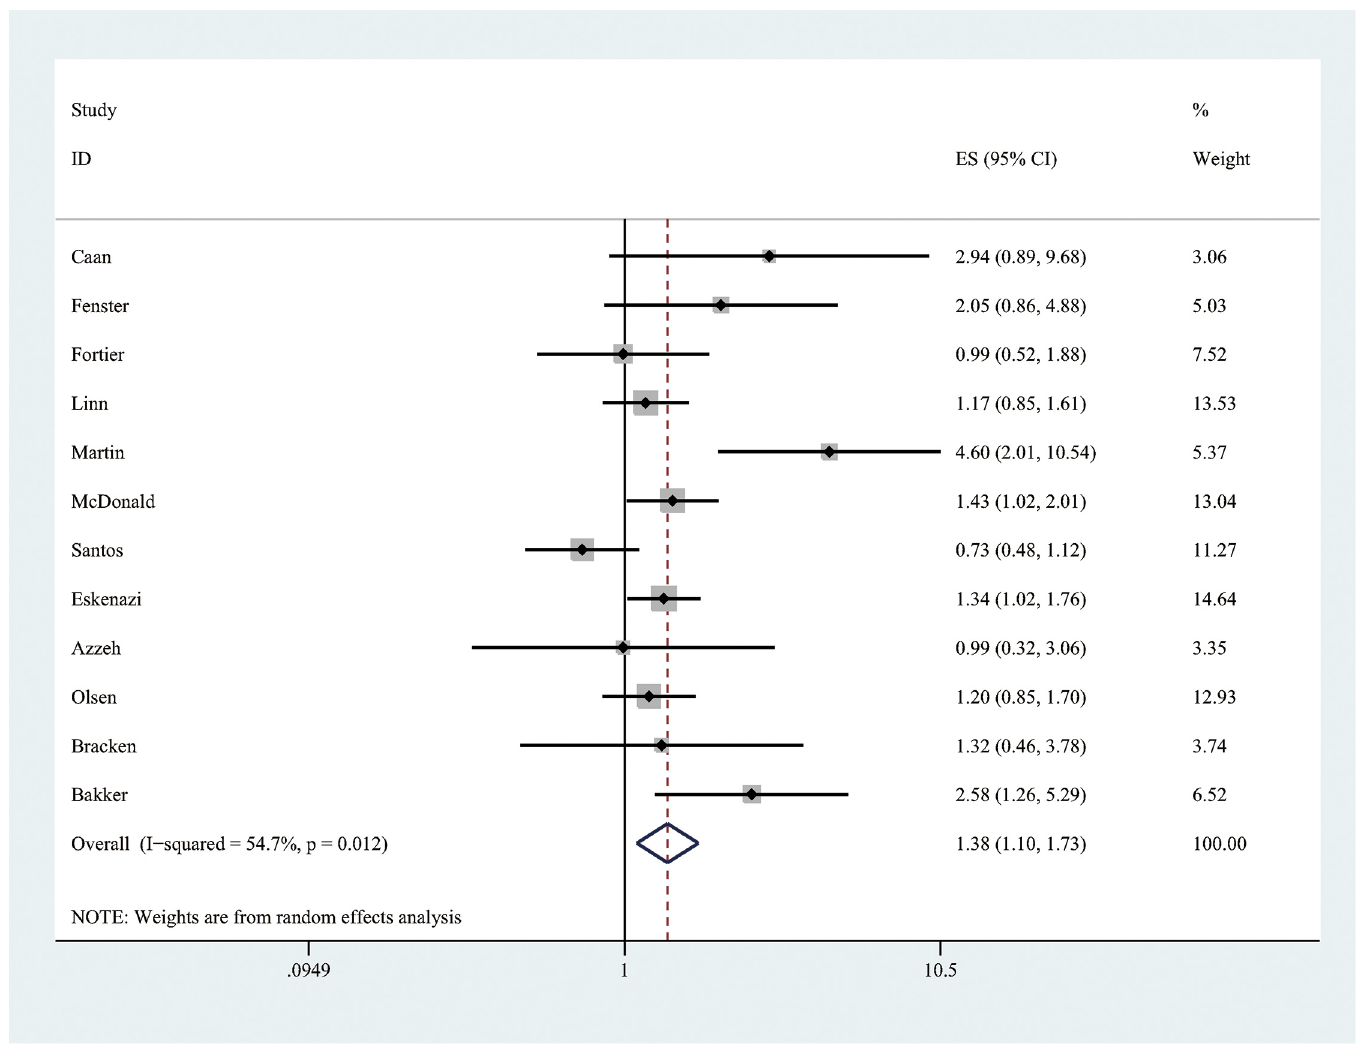
Fig 2. Forest plot of meta-analysis by using random effects model for the effect of maternal caffeine intake during pregnancy on the risk of low birth weight (comparing highest versus lowest levels).